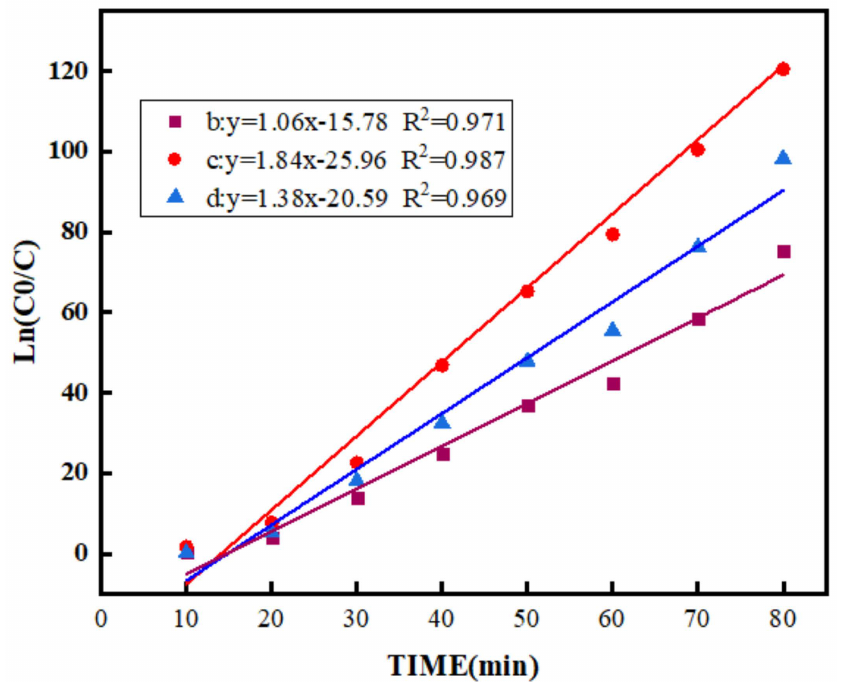
Figure 10. First-order kinetics of hierarchical Zn-ZSM-5 photocatalyst structures with different Zn/Si